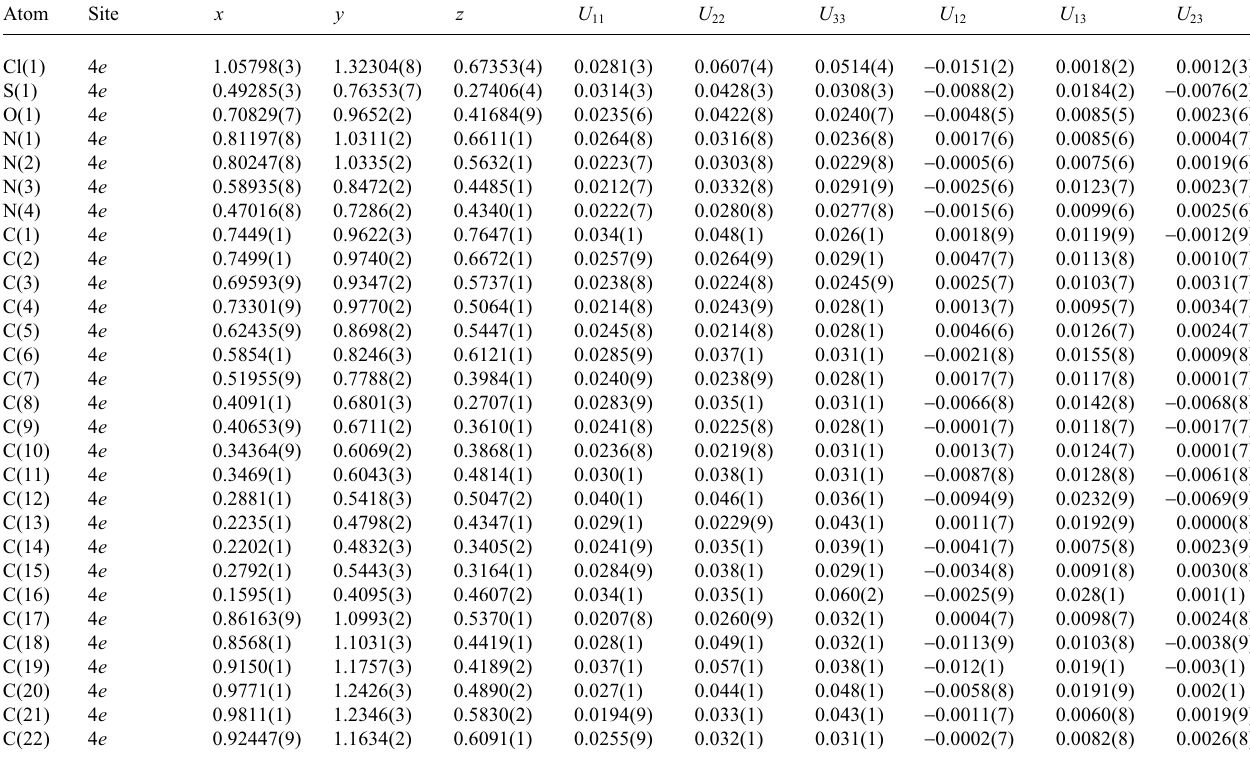
Table 3. Atomic coordinates and displacement parameters (in Å 2 )